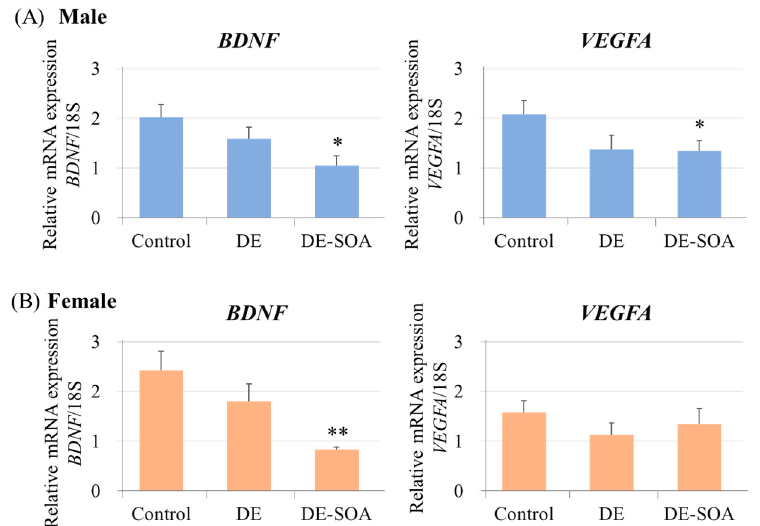
Figure 7. Messenger RNA expression levels of neurotrophins in the hippocampus. BDNF and VEGFA in the hippocampus of 10-week-old ( A ) male and ( B ) female rats of the control and the DE- or DE-SOA-exposed groups. ( n = 10, ** p < 0.01, * p < 0.05 vs. control).